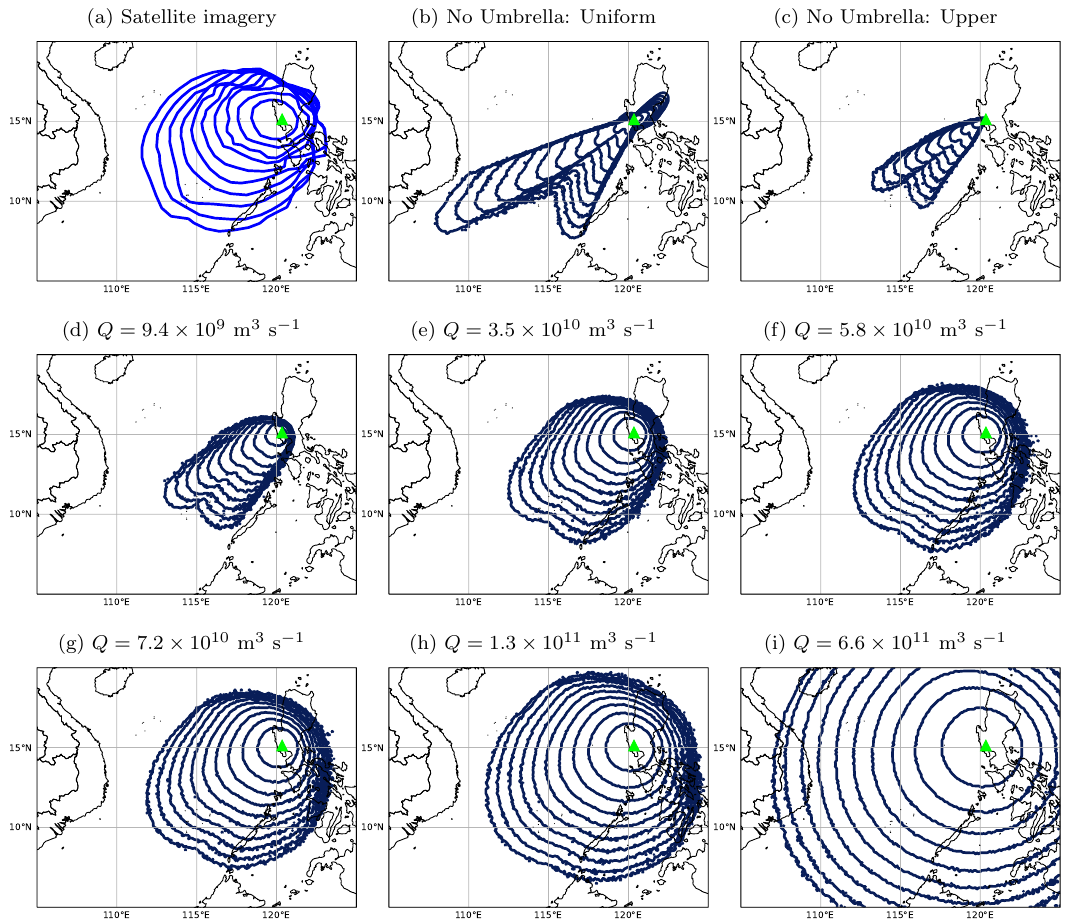
Figure 1. Observed ( a ) and modelled ( b – i ) growth of the Pinatubo umbrella cloud at hourly intervals from 05:40 to 14:40 UTC on 15 June 1991. Simulations ( b , c ) do not use the umbrella cloud parameterisation and are described in Section 5. Simulations ( d – i ) use the umbrella parameterisation with different estimates of the volume flow rate, Q . The modelled ash contour denotes ash column loads of 0.5 g m − 2 (approximately the ash detection level of satellite instrumentation) and indicates an outline of the predicted umbrella cloud. Satellite observations are digitised from Holasek et al. [12]. The volcano location is marked by a green